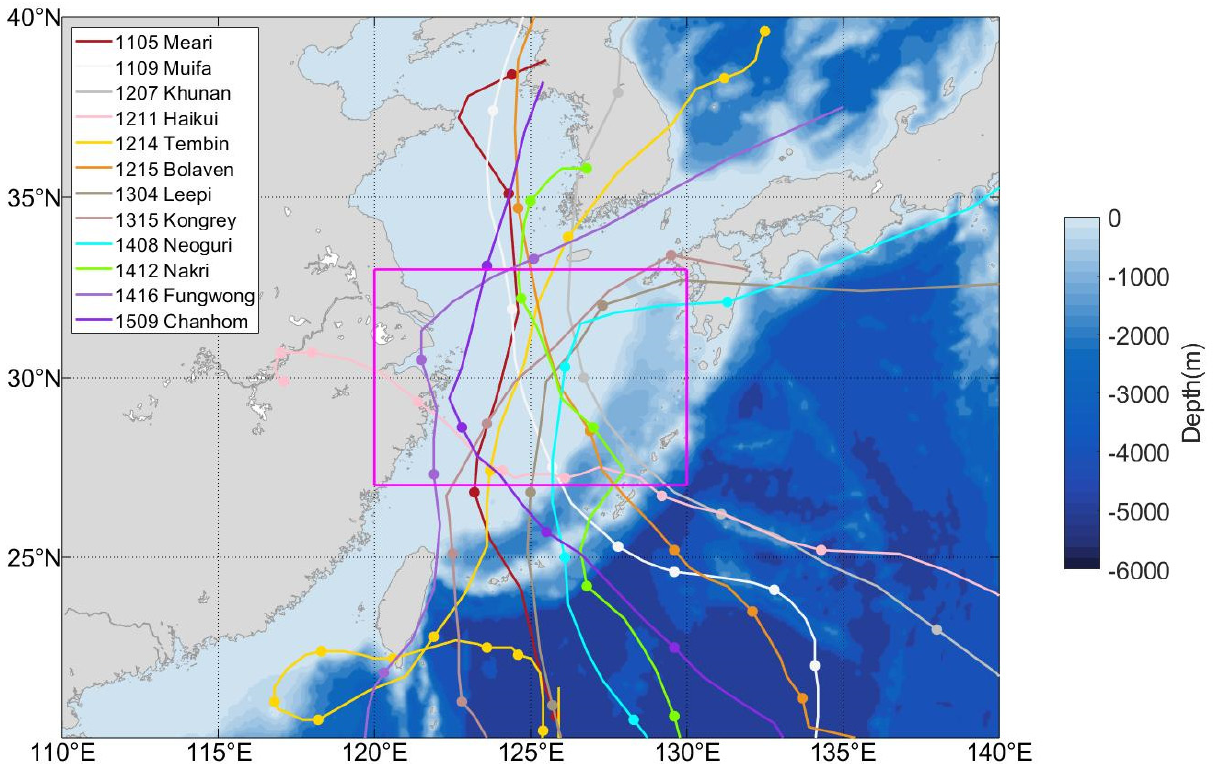
Figure 1. Bathymetry of the East China Sea and tracks of the 12 typhoons. The magenta box denotes the study domain, Zhejiang coastal waters.